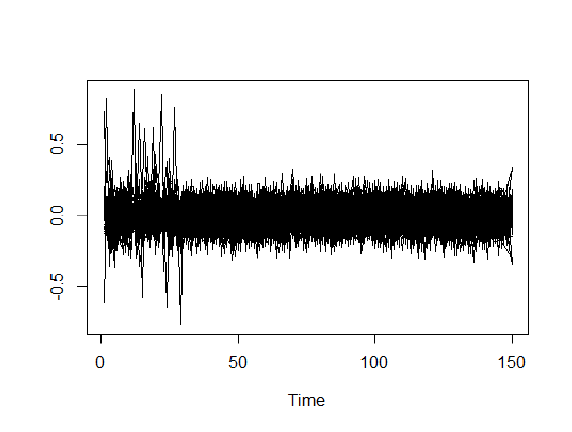
The bandwidths h H ∼ h K =: h are automatically selected by cross-validation method on the K-nearest neighbours ([27]).